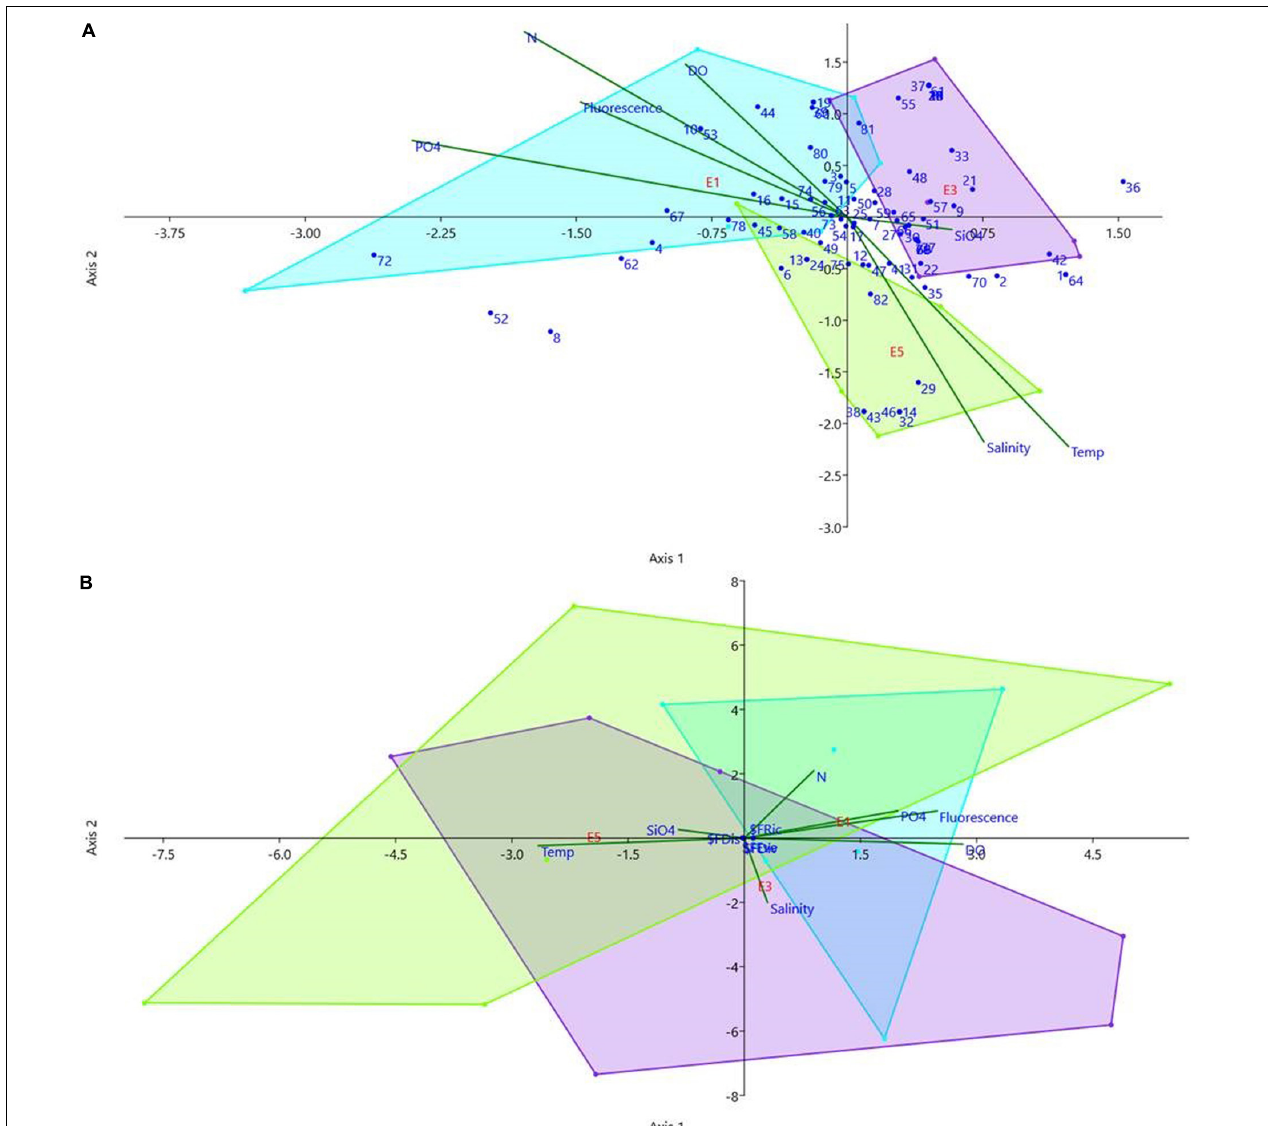
FIGURE 6 | Canonical correspondence analysis of microphytoplankton comparing the density (cells.L − 1 ) (A) the species were numbered according to Table 5 and functional traits indices (B) with the environmental analysis [Salinity, Temp ( ◦ C)—temperature, Flu—fluorescence, N—nitrogen compounds (NO 2 − + NO 3 − ), PO 4 —phosphate, SiO4—silicate and DO—dissolved oxygen] in all the eddies stations. Legend- blue: E1; purple: E3 and green: E5, the color convex hull was divided by the eddy data, each eddy received a color to represent in the